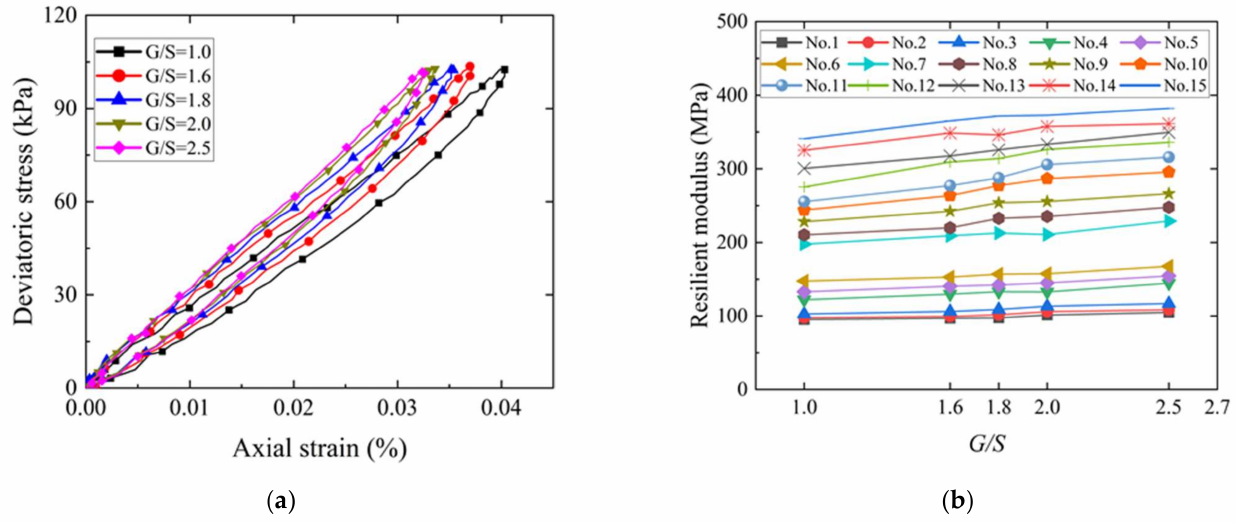
Figure 13. Effect of different gradations (G/S values) on the resilience modulus of unbound granular materials recycled from CDW: ( a ) Hysteresis curves of the deviator stress versus axial strain. ( b ) The resilient modulus versus